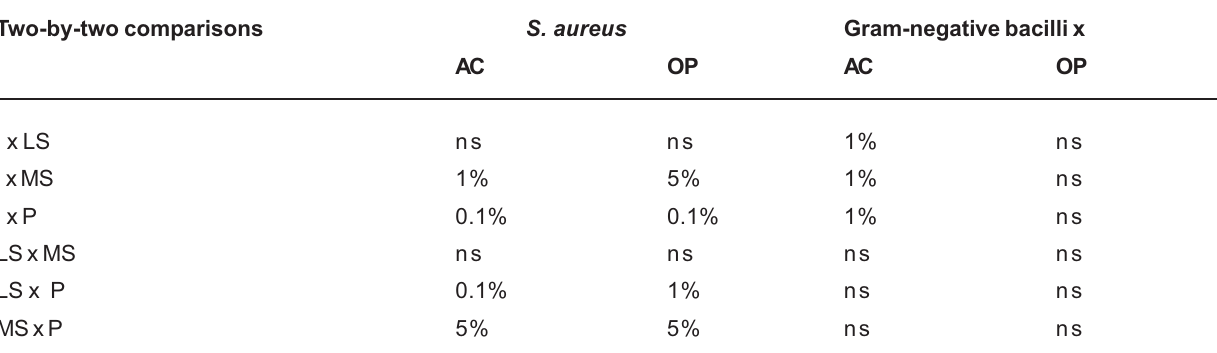
*Statistically significant at 1% level TABLE 4- Results of the Friedman’s test for the presence of S. aureus and gram-negative bacilli